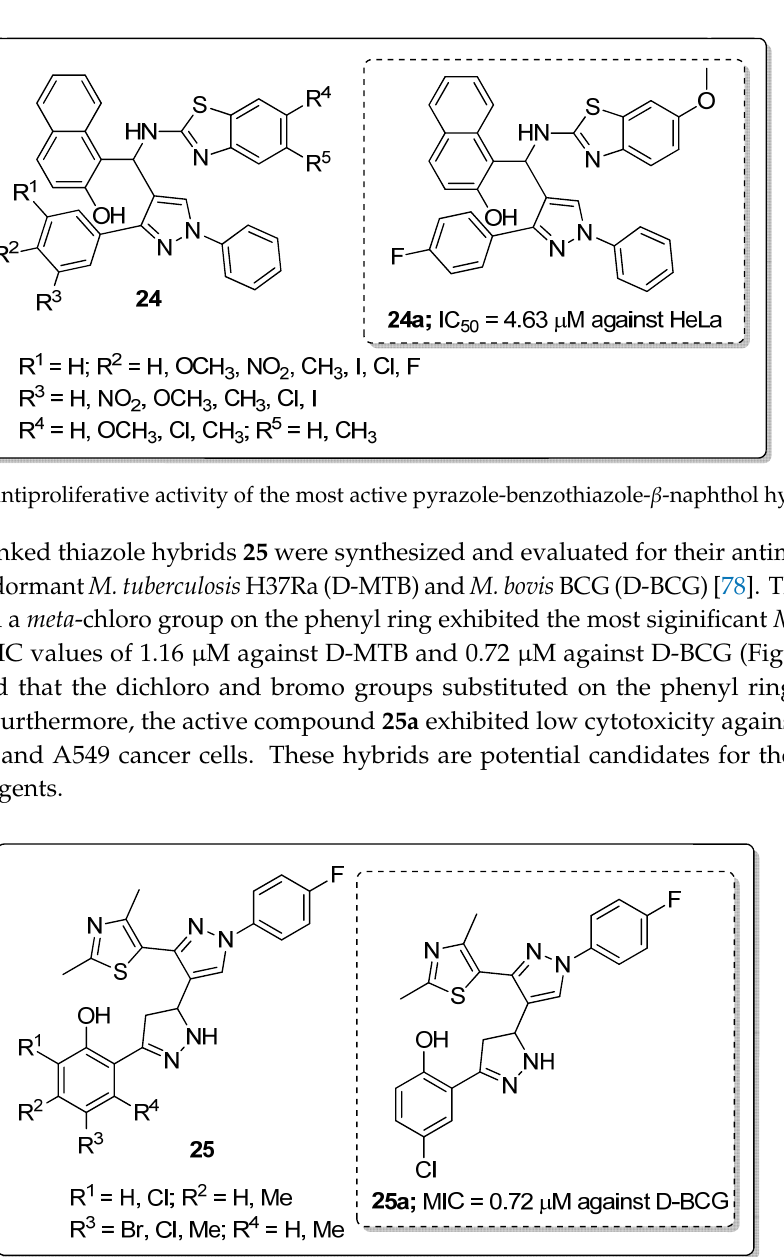
Figure 30. PTP1B inhibitory activity of most active pyrazole conjugate 26a .